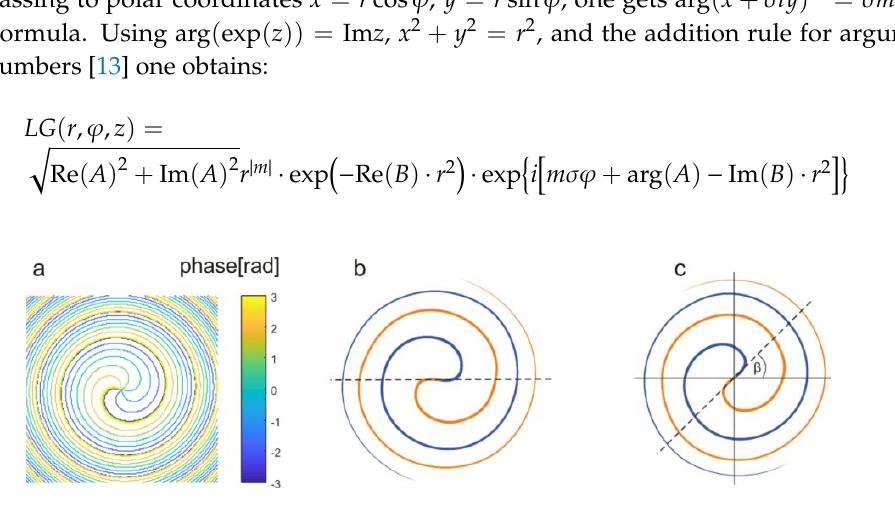
Figure 1. ( a ) Equiphase lines from Equation (1) form a set of spirals, each spiral can be viewed as single branches of Fermat’s spirals (case m = 1); ( b ) Lines of the constant phase 0 and π form a complete Fermat’s spiral (both branches plotted with different colors) , (b ) tangent line φ = 0; ( c ) Tangent line ϕ = − b 2 / a